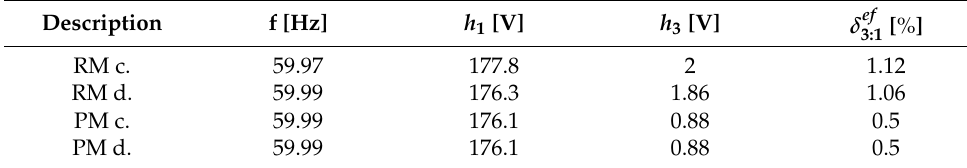
Table 4. No load simulation.